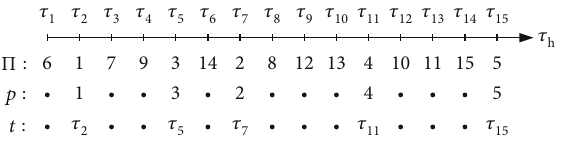
Figure 4: Example of permutation decoding for a discrete time- length tour with N = 5 and D = 3